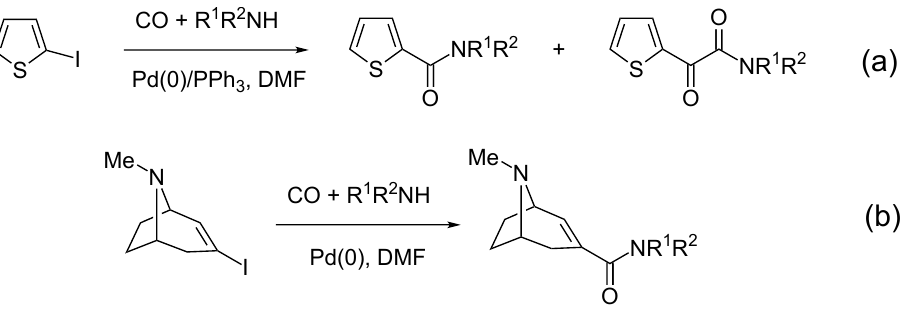
Figure 5. Aminocarbonylation of 2-iodotiophenes ( a ) and tropenes ( b ). N-acylated prolinates were synthesized from various iodoalkenes and iodoarenes reacting with methyl and benzyl prolinate. From iodobenzene and all the iodoalkenes only the formation of amides was observed, from iodonaphtalene a mixture of amides and ketoamides was obtained [42]. In the aminocarbonylation of various alkenyl and (hetero)aryl iodides tropane-based amines of biological importance were used, such as 8-azabicyclo[3.2.1]octan-3-one (nortropinone) and 3 α -hydroxy-8-azabicyclo[3.2.1]octane (nortropine) as N-nucleophile. With iodoalkenes, the N -nucleophiles were selectively con- verted to the corresponding amide in the presence of Pd(0)/2 PPh 3 catalysts. In the presence of iodo(hetero)arenes, the application of the bidentate Xantphos was necessary to eliminate the double carbonylation, thereby producing the target compounds selectively